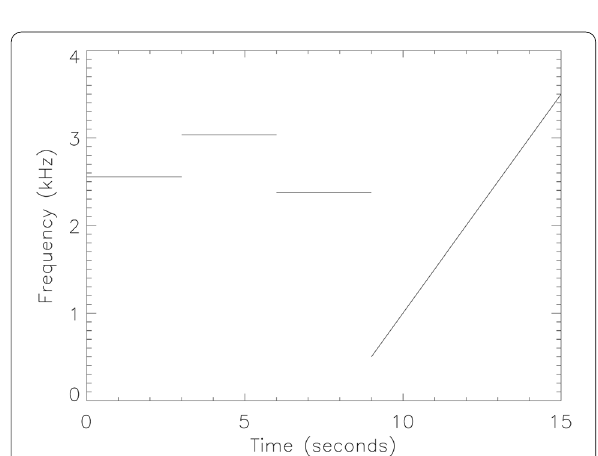
Fig. 16 Pulses and ramp triggered by HAARP during the case 4 when DEMETER is in the Southern